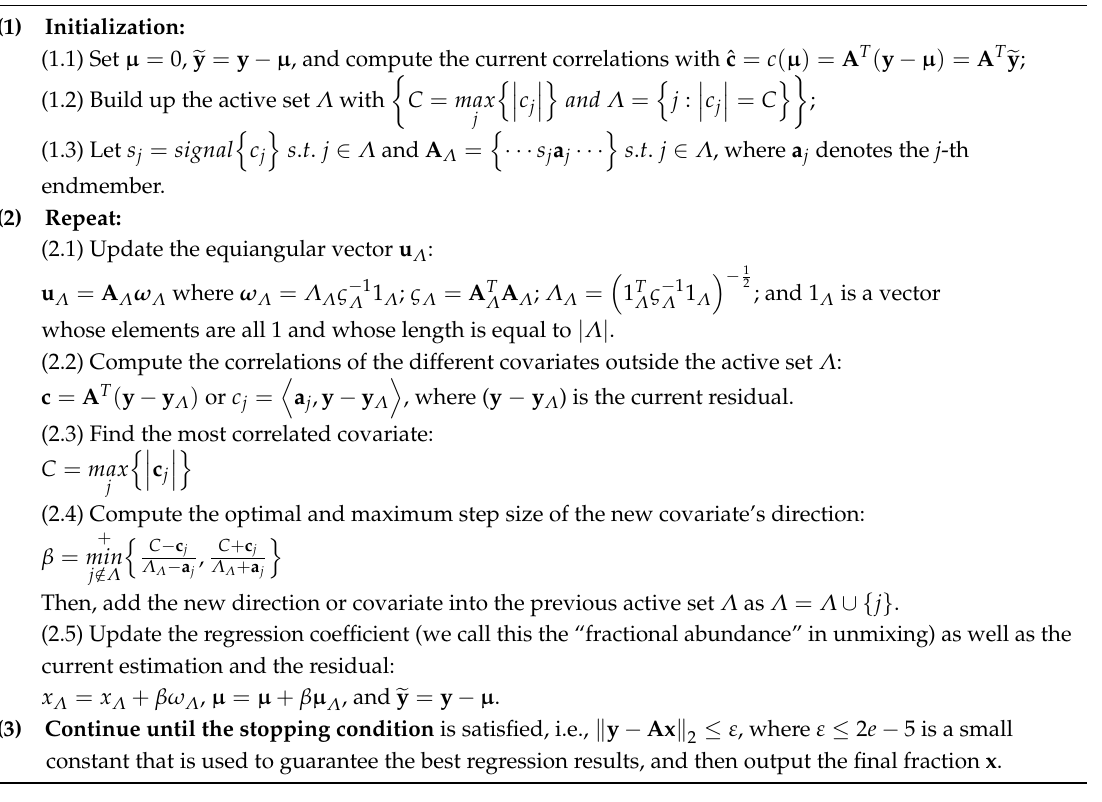
Algorithm 1 The Least Angle Regression-Based Constrained Sparse Unmixing